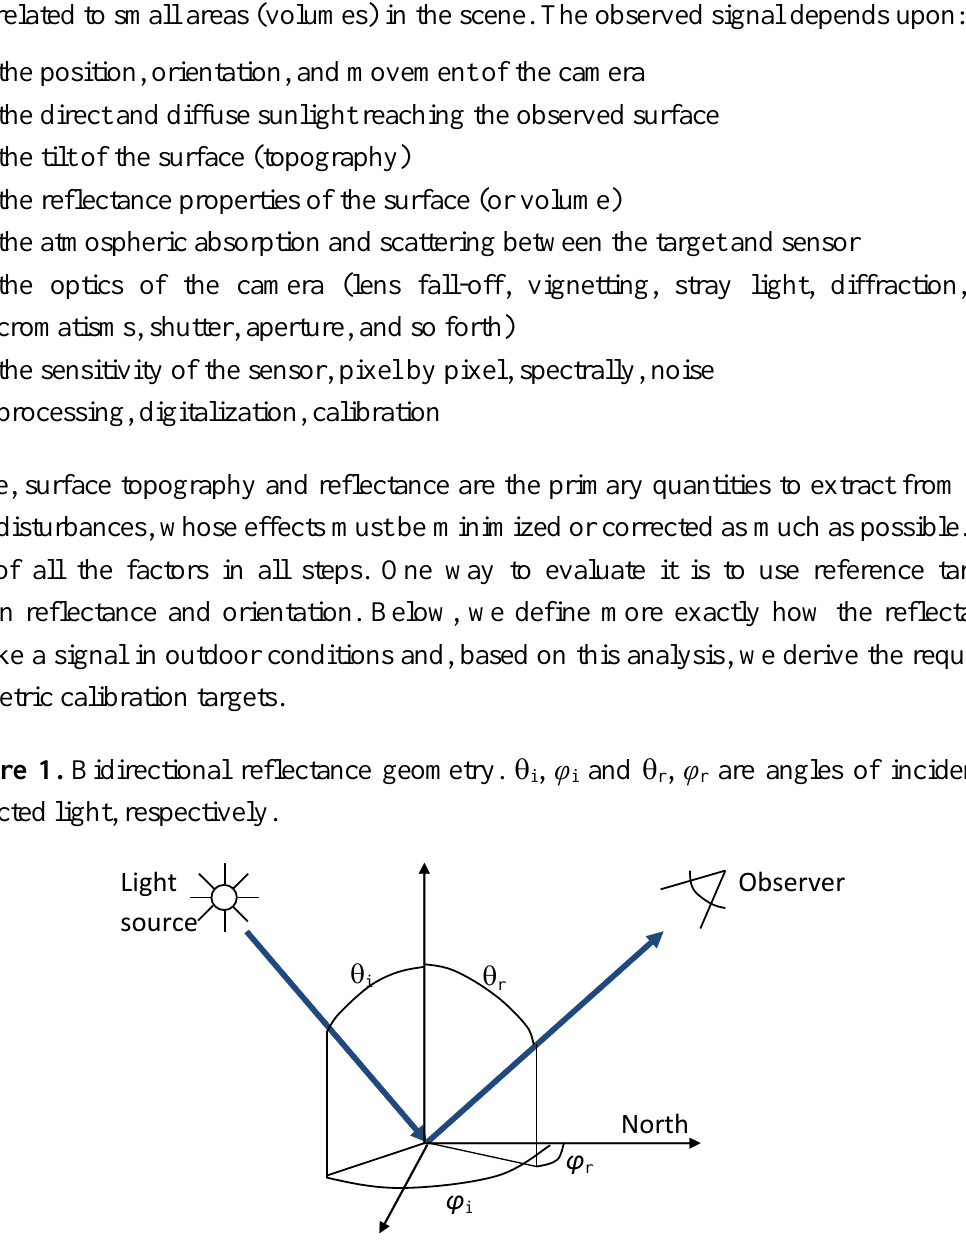
, φ and  , φ are angles of incident and i i r r